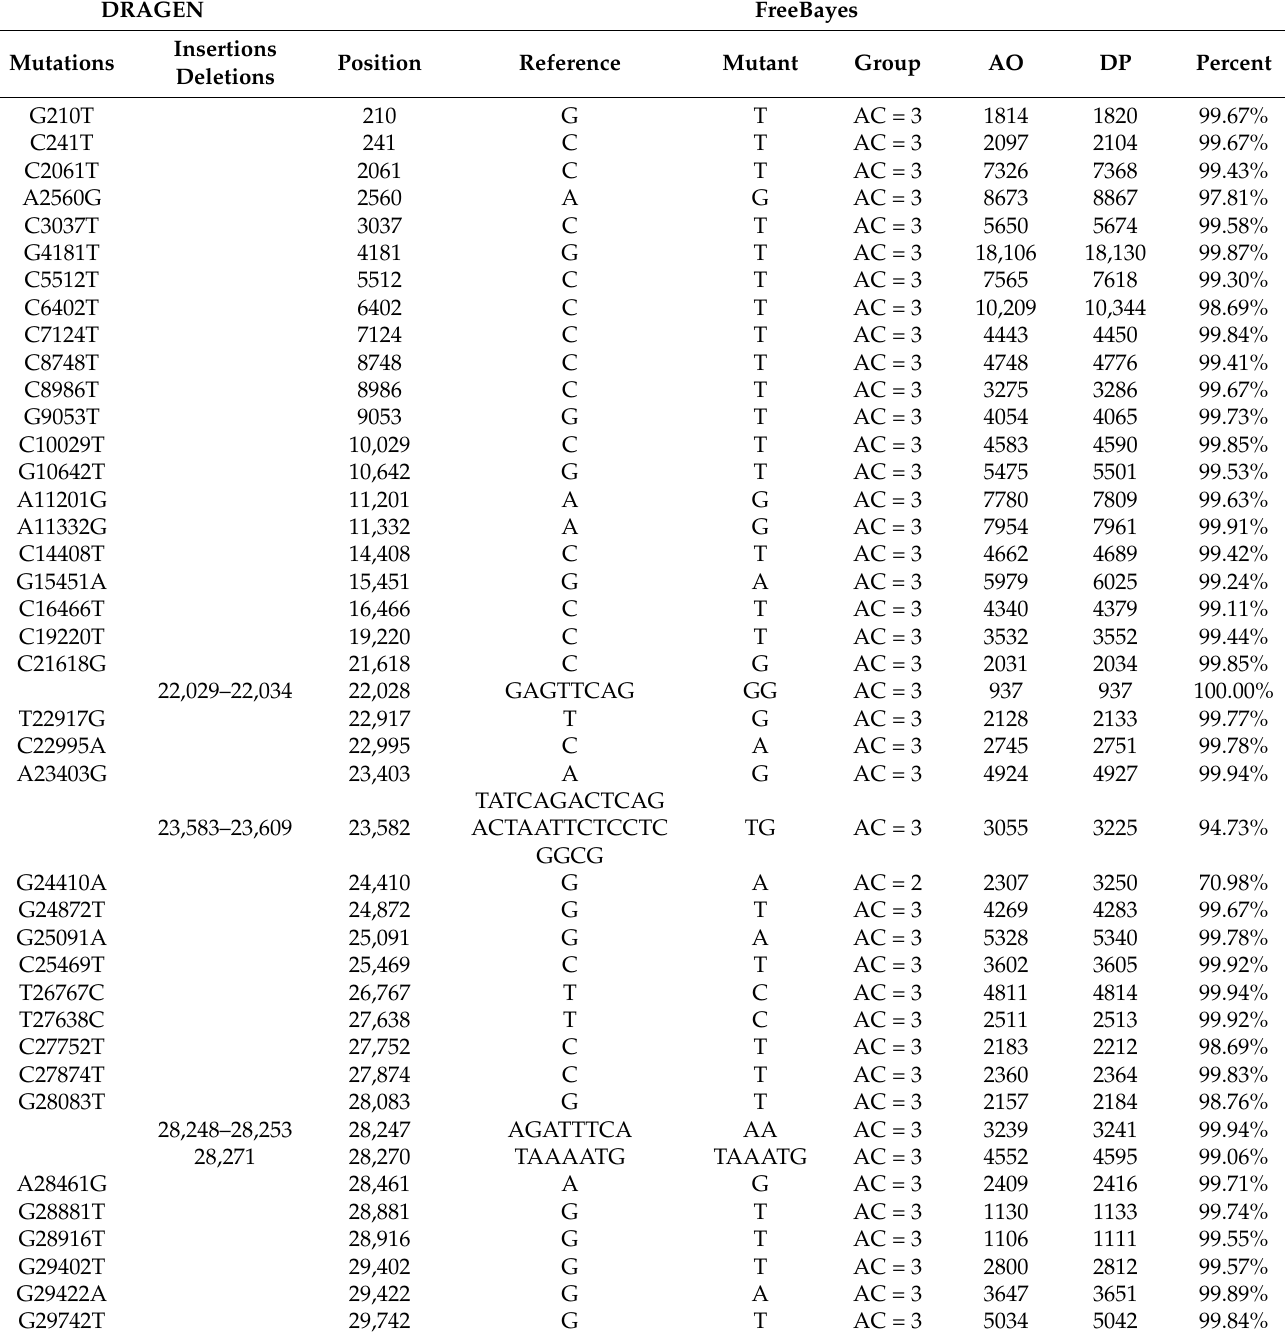
Table 4. Mutations present in sample